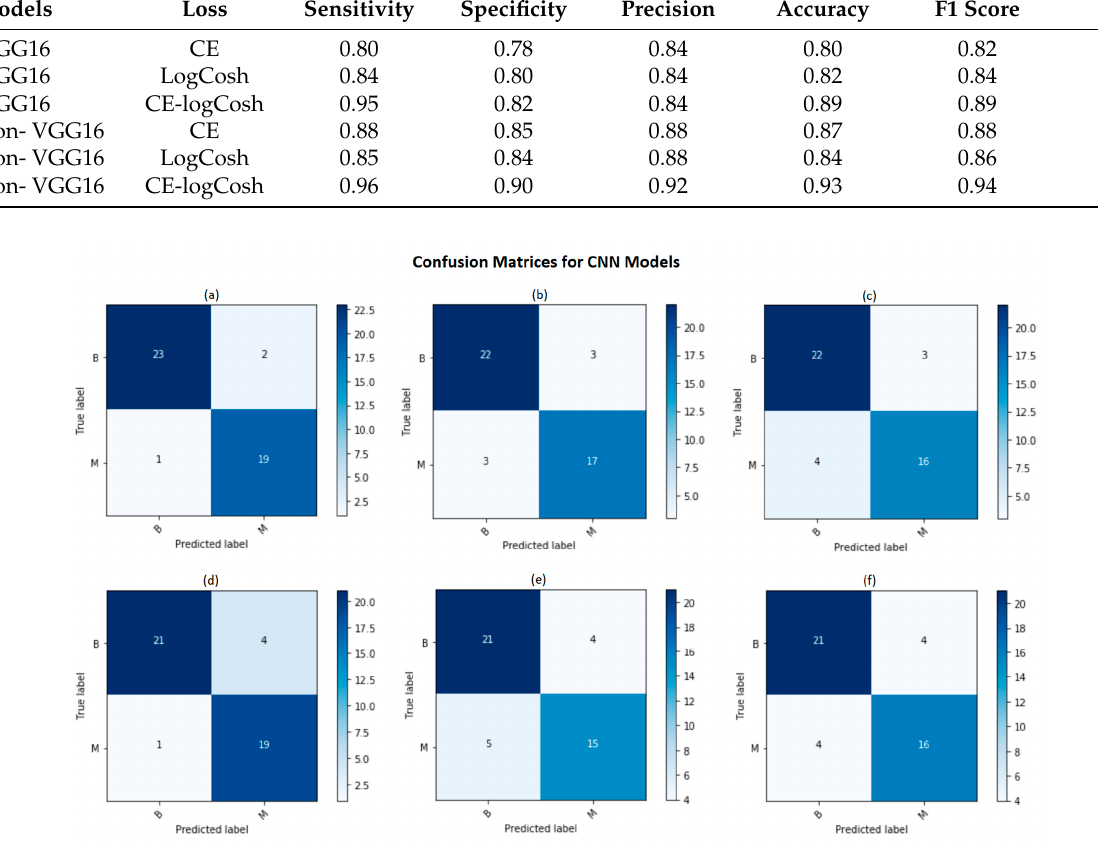
Figure 5. Illustration of confusion matrices for different models. ( a ) Attention-VGG16 with CE-logCosh loss, ( b ) Attention- VGG16 with CE loss, ( c ) Attention-VGG16 with logCosh loss, ( d ) VGG16 with CE-logCosh loss, ( e ) VGG16 with CE loss, and ( f ) VGG16 with logCosh loss.